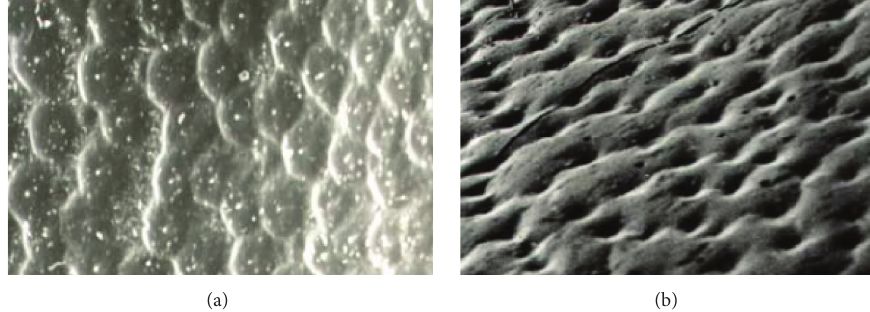
Figure 2: Convex surface of dung beetle’s head (a) and concave surface of dung beetle’s chest (b).